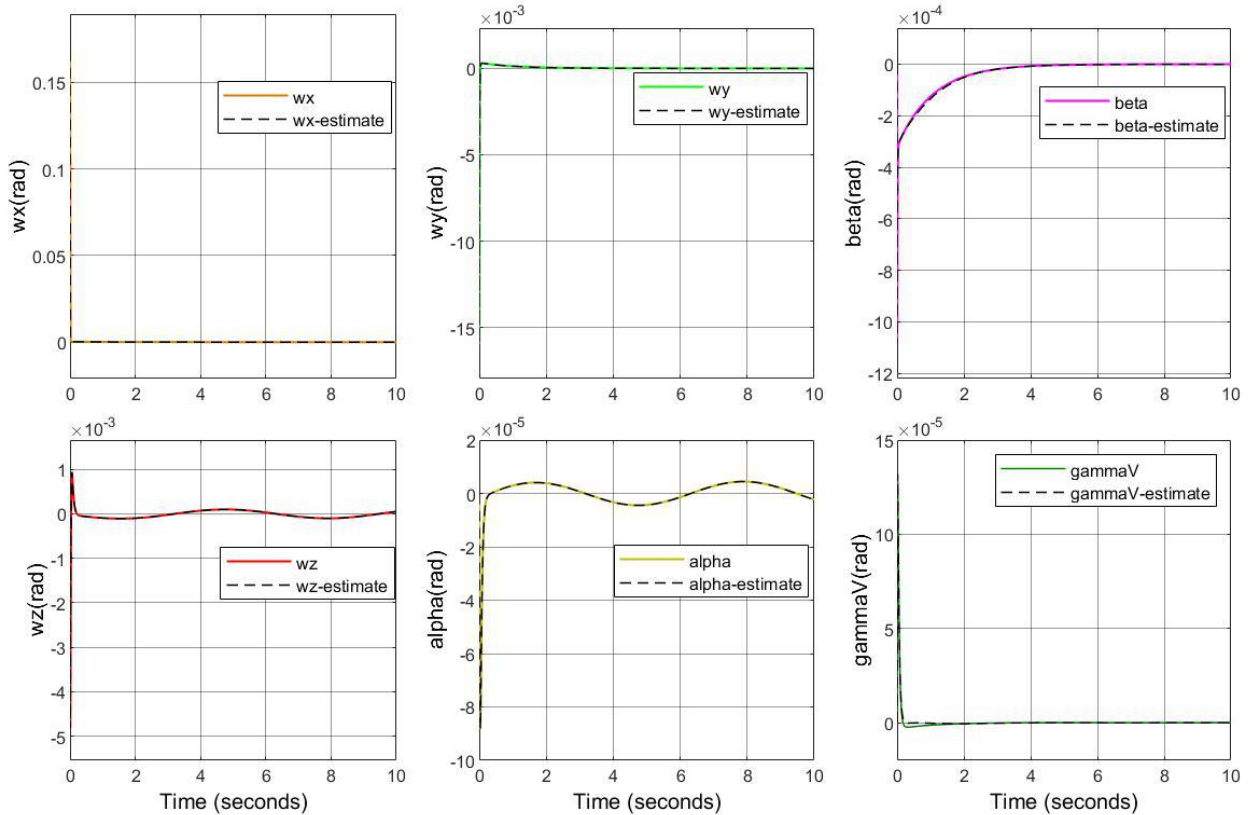
Figure 2. State estimation by the sliding mode observer without actuator faults.